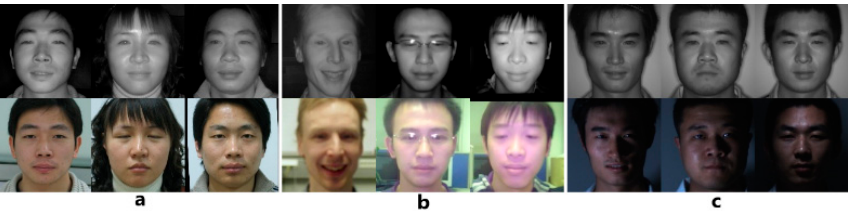
Figure 1. Paired near infrared-visible (NIR-VIS) images in three datasets ( a – c ) for the CASIA NIR- VIS 2.0, Oulu-CASIA NIR-VIS and BUAA VIS-NIR datasets,